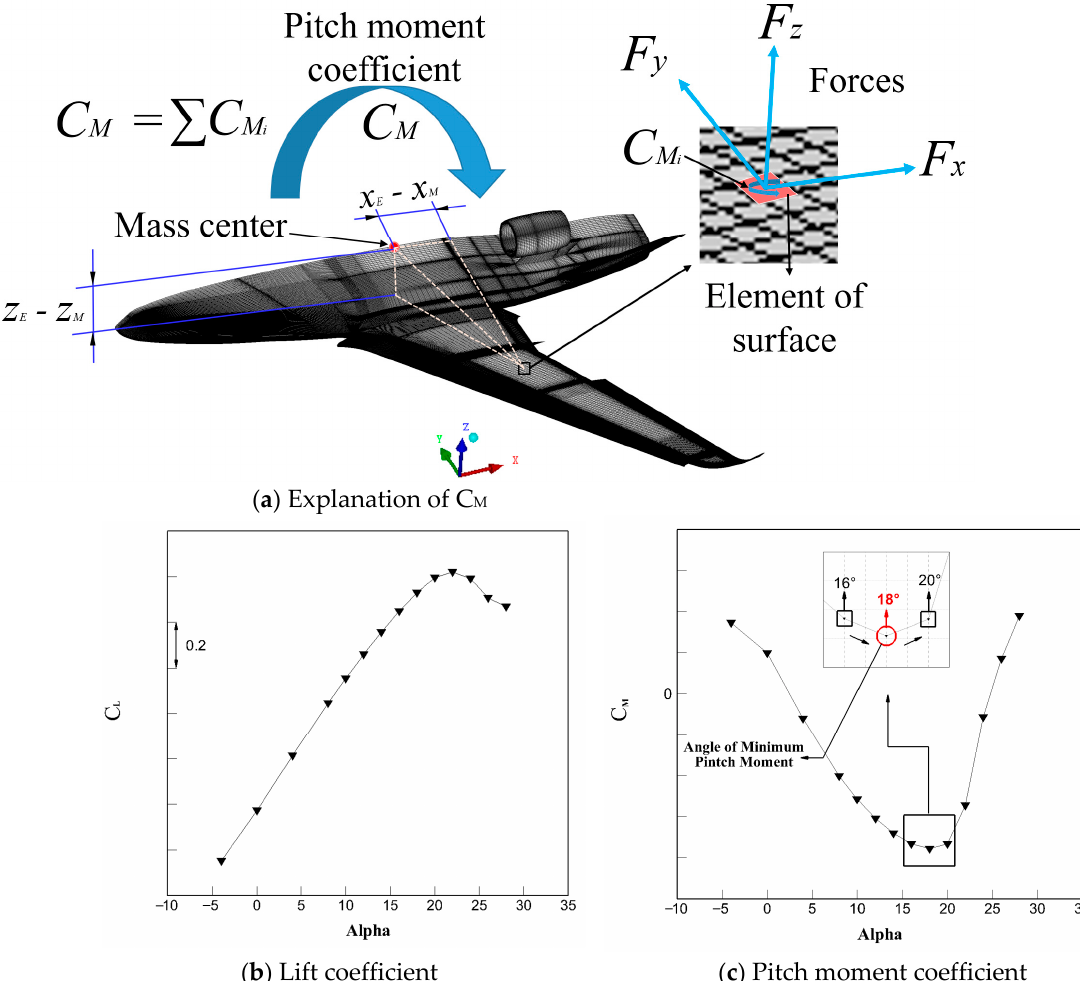
Figure 9. Aerodynamic coefficient of the high lift configuration in real condition.